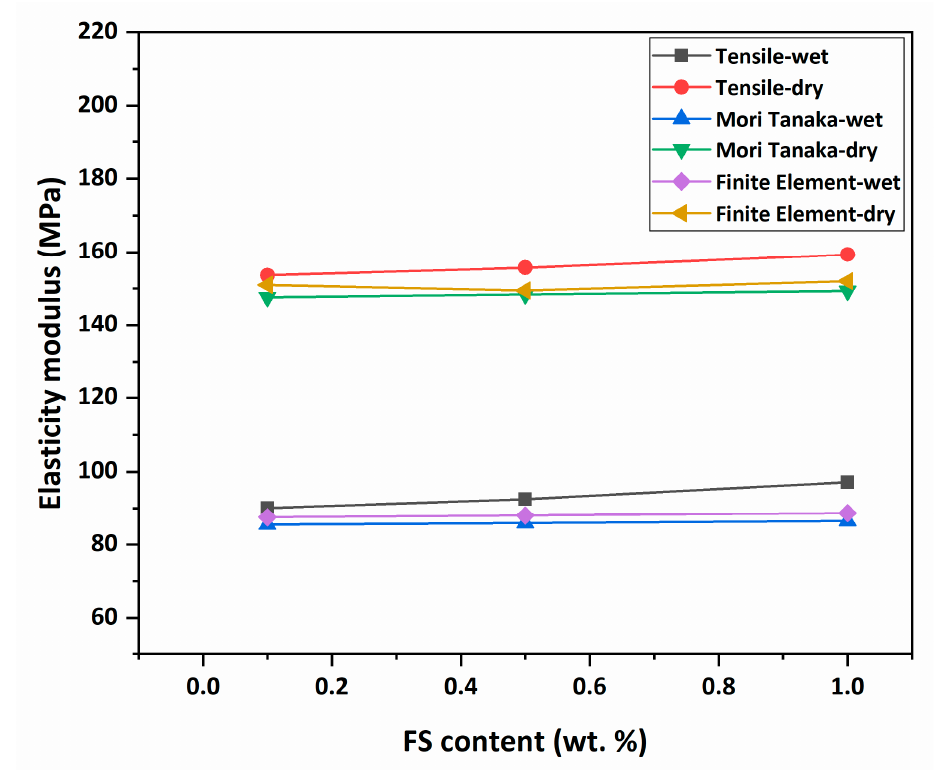
Figure 10. Elasticity modulus change of samples.